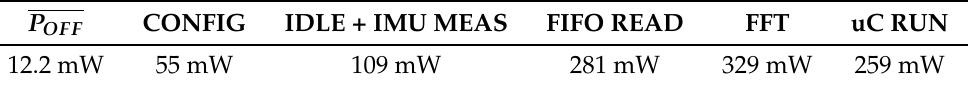
Table 5. Average power consumption of the events generated in the RT controller power